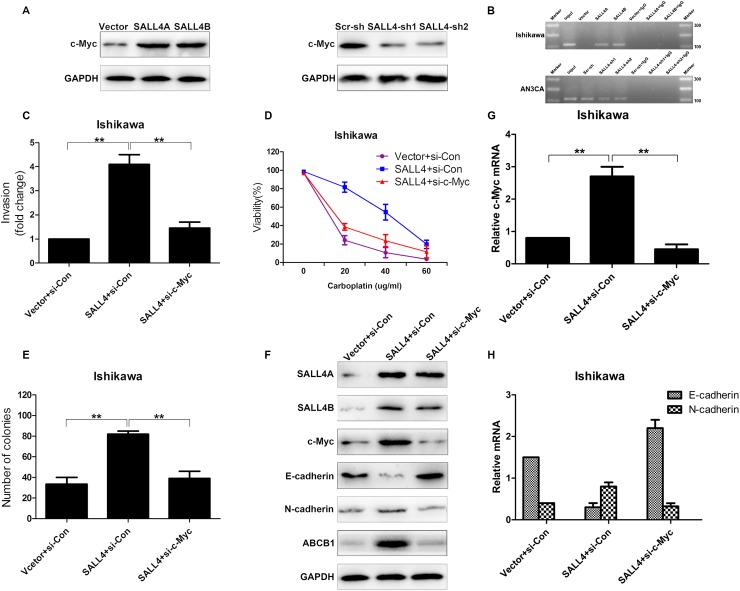
c-Myc is required for EMT and chemotherapy resistance by SALL4-induced.(A) The expression of c-Myc was positively associated with that of SALL4 in Ishikawa and AN3CA cells by western blotting analysis. (B) c-Myc was a direct target of SALL4 through ChIP assay. (C) Downregulation of c-Myc by specific siRNA reduced SALL4-induced invasion in Ishikawa cells overexpressing SALL4 by transwell assay. (D)(E) Downregulation of c-Myc reduced SALL4-induced drug resistance in Ishikawa cells overexpressing SALL4 through viability assay and clone formation assay. (F) The expression of EMT-related markers and ABCB1 was assessed by western blotting in Ishikawa cells. (G)(H) The mRNA levels of c-Myc, E-cadherin and N-cadherin were detected through qRT-PCR in Ishikawa cells. **P<0.01.